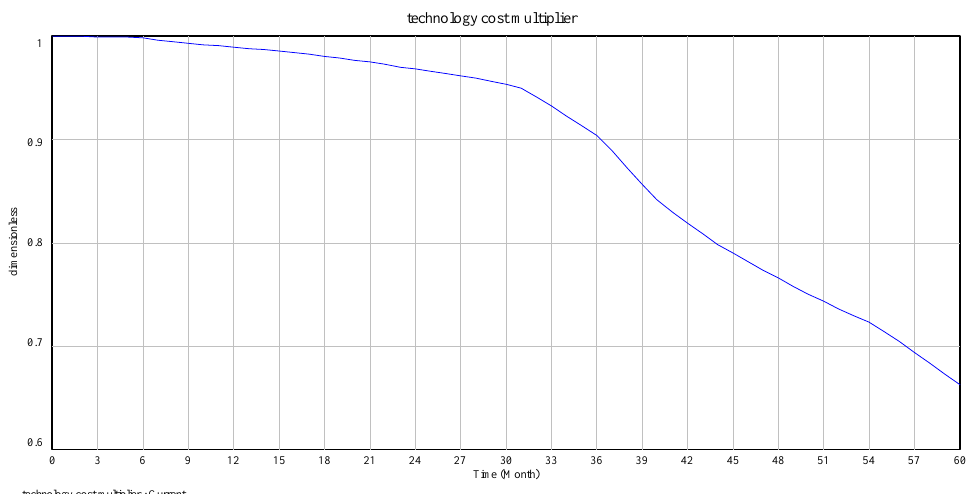
Figure 6. Technology cost multiplier.